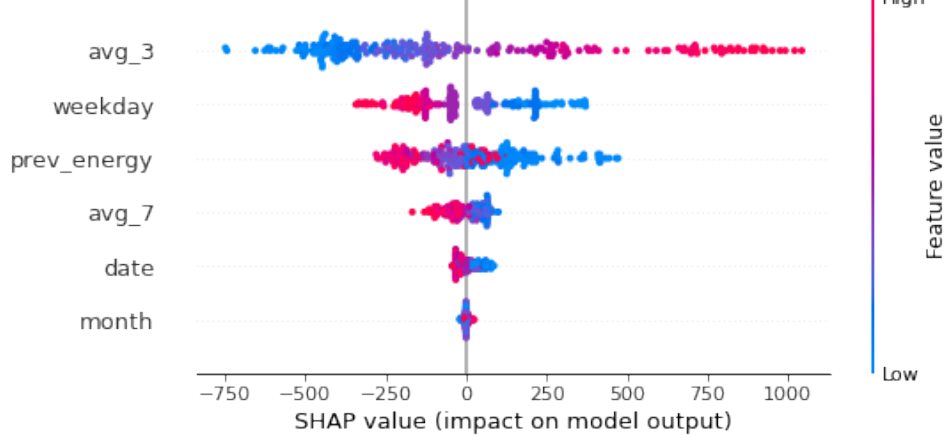
Figure 6. Beeswarm plot for the best-performing